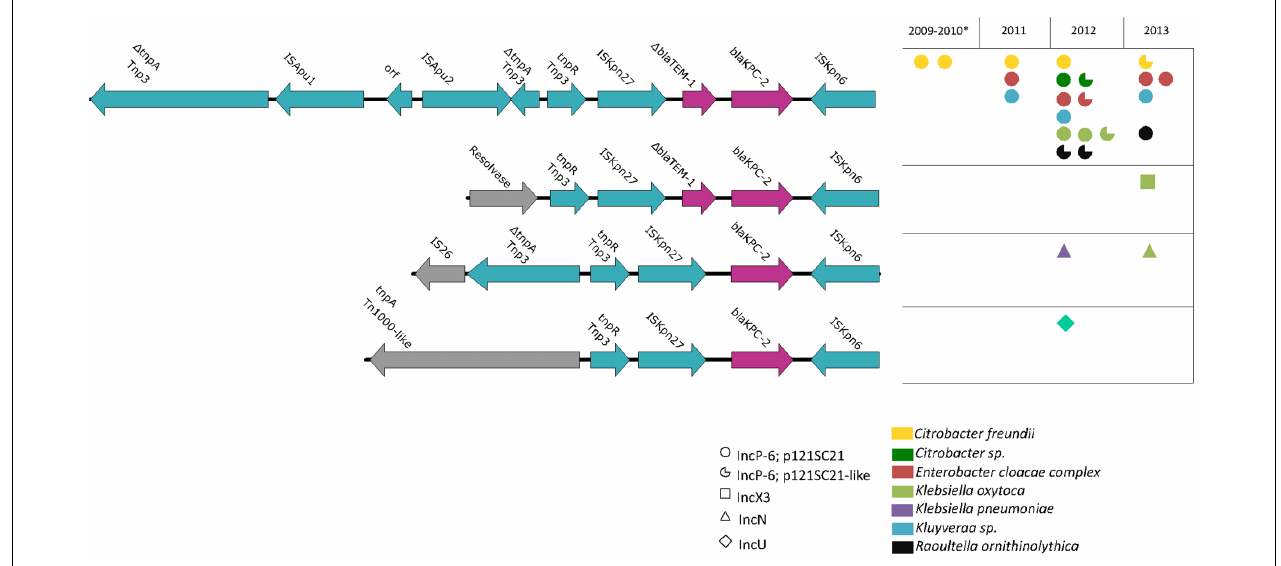
FIGURE 3 | Genetic bla KPC - 2 environments and their distributions. Four different genetic environments of the gene bla KPC - 2 were present in plasmids of different incompatibility groups of IncP-6, IncX3, IncN, and IncU. The locus adjacent to the Tn 3 - tnpR was variable. The predominant genetic environment, IncP-6 type, contained a disrupted Tn 3 transposase by insertion of an IS Apu1 /IS Apu2 -element and was encountered in 21 isolates belonging to several species during the whole period and in isolates of both clinical and wastewater